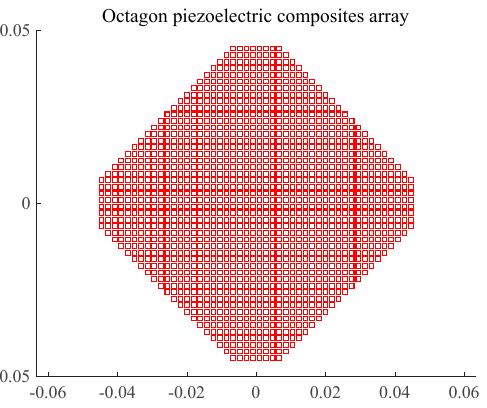
Figure 8. Octagonal 90° Rotating Symmetric Composite Transmitting Array Structure. In the figure, the short side of the octagon array is 15 mm long, the long side is 75 mm long, and the vertical and horizontal lengths are 91 mm